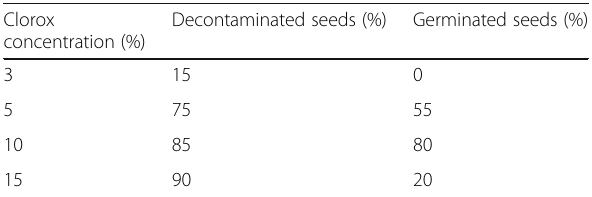
Table 1 Effect of Clorox concentrations at 10 min exposure time on decontamination and germination rate of seeds of S.